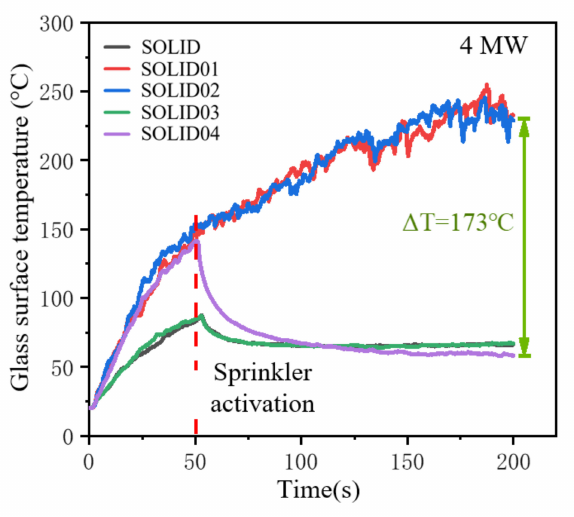
Figure 18. Glass surface temperature change under window sprinkler